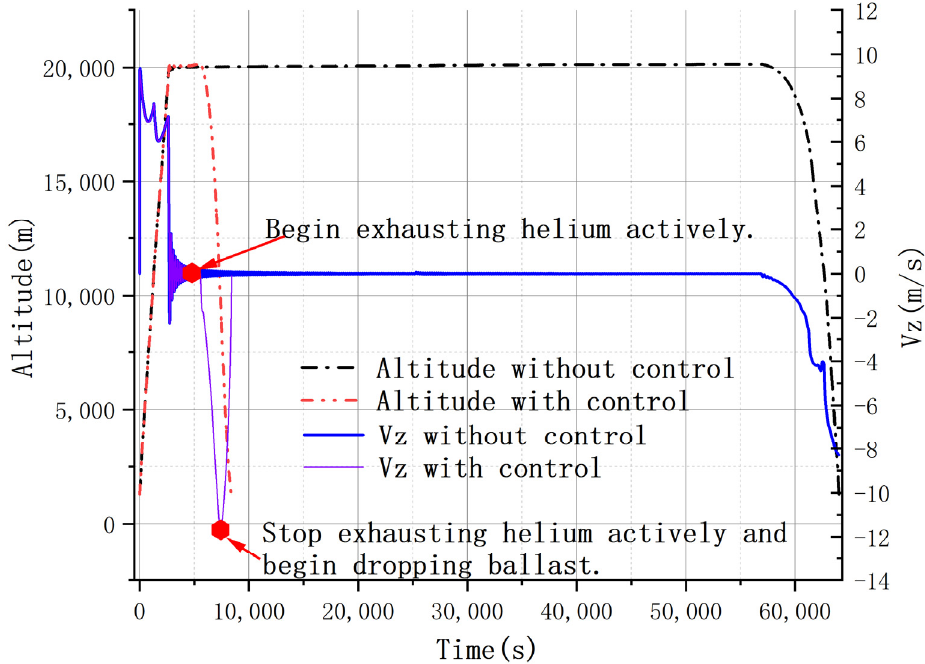
Figure 16. Simulation results of Mission A: balloon system’s change in vertical speed vs. time and change in altitude vs. time while the control strategies are applied (or not).